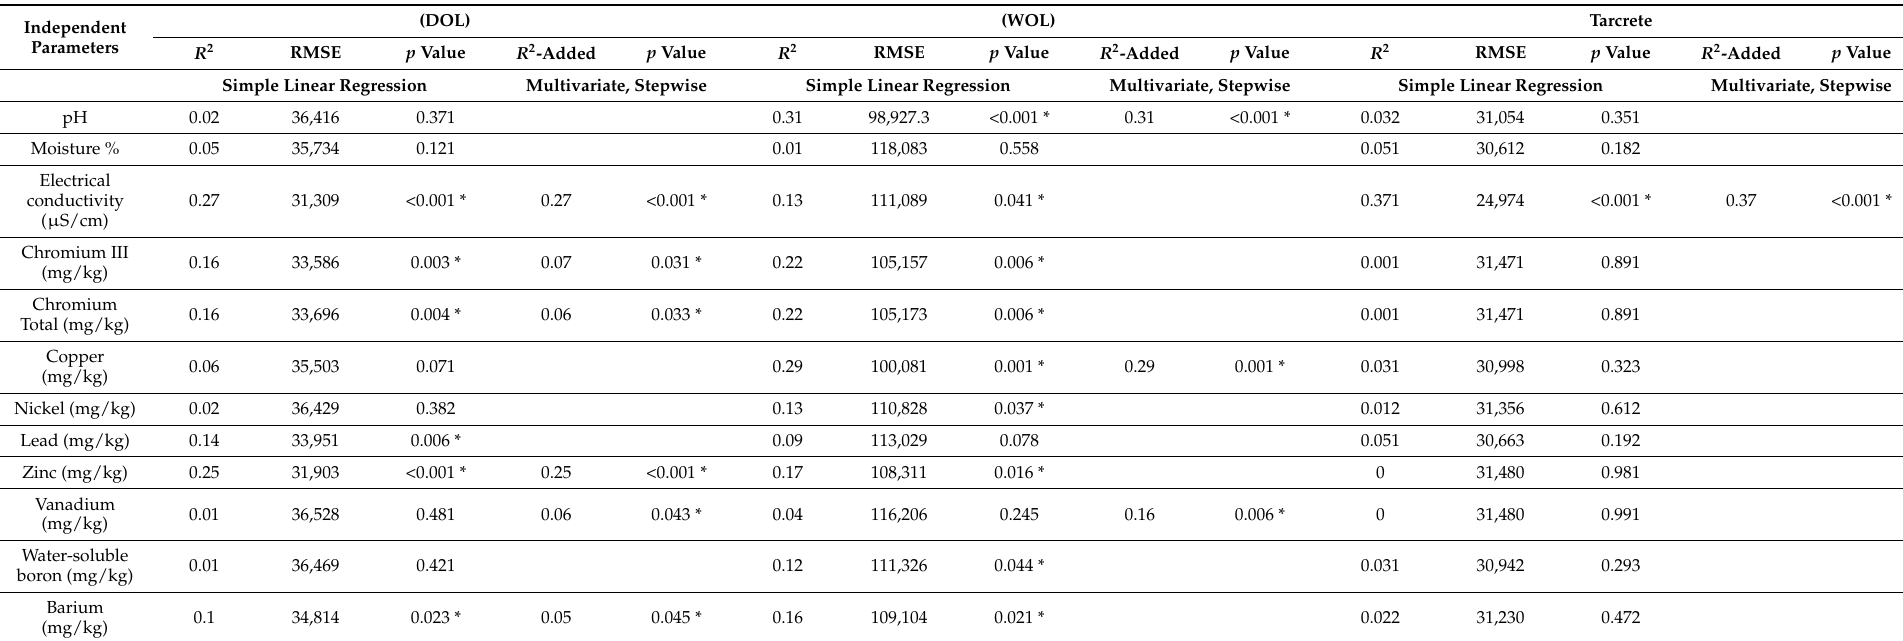
Table 4. Summary of regression analysis results between TPH and soil parameters in three TPH-contaminated